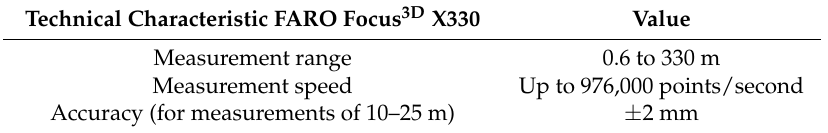
Table 3. Technical characteristics of terrestrial LiDAR FARO Focus 3D X330 provided by the